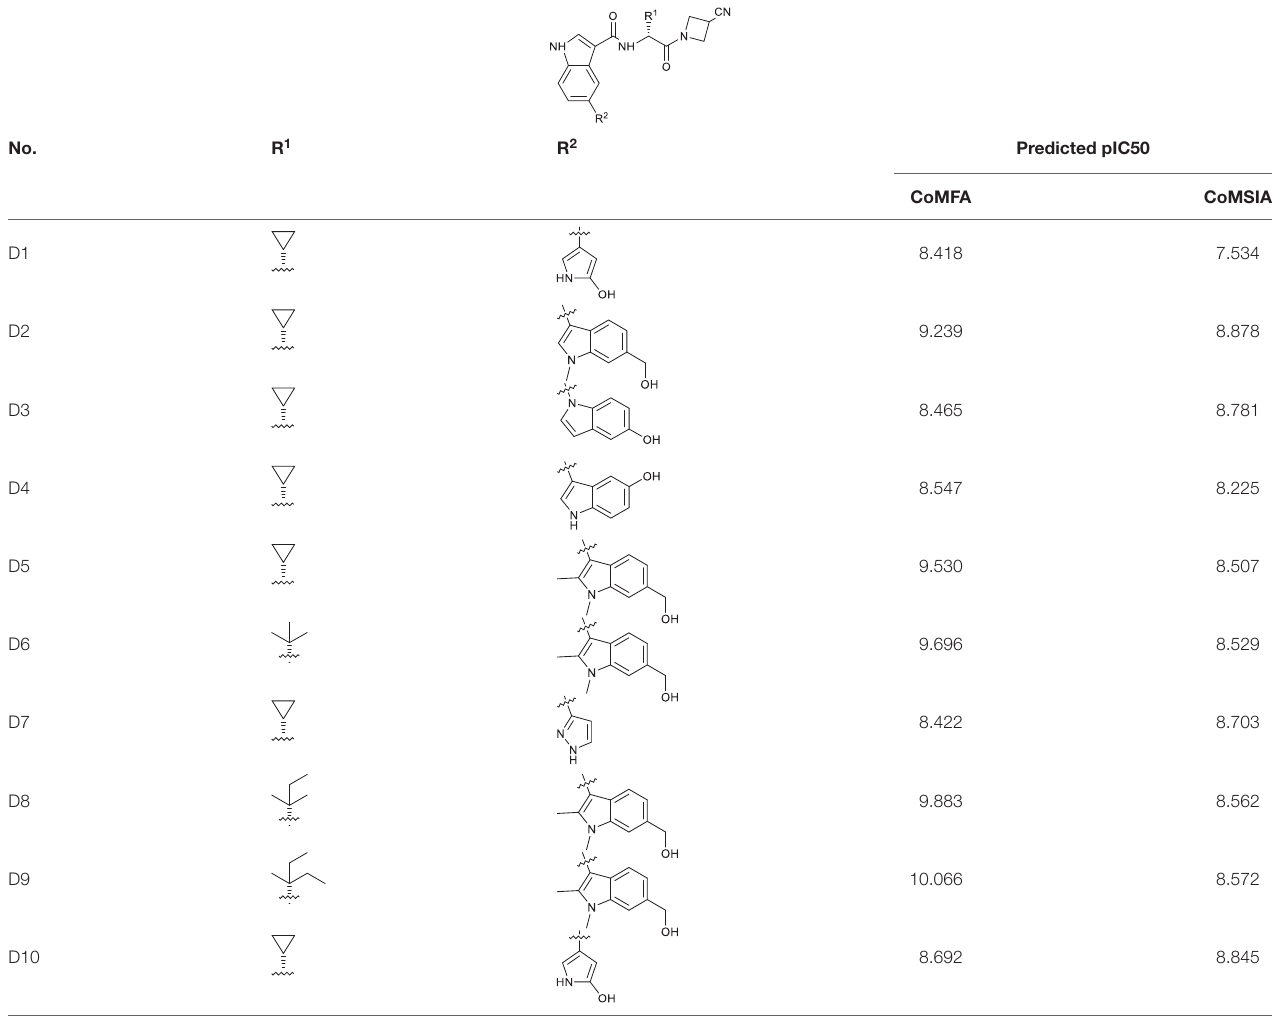
TABLE 4 | The 2D structures, predicted activities of 10 novel JAK3 inhibitors.